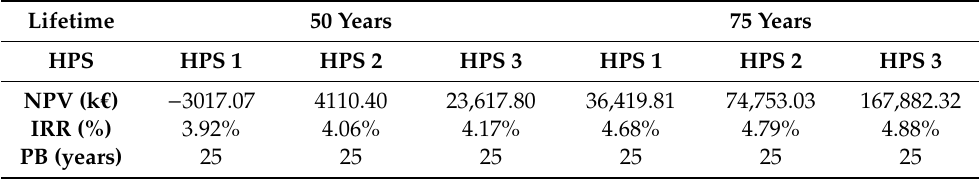
Table 5. Profitability analysis of HPS 1, HPS 2 and HPS 3, considering the construction of new tunnels, DTCs of 8 h and lifetimes of 50 and 75